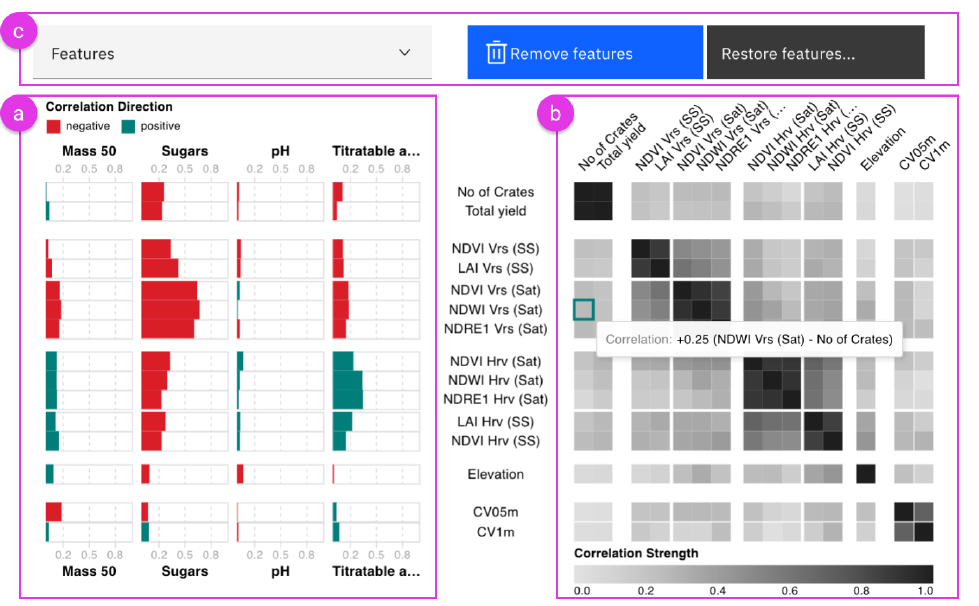
Figure 2. Interface for correlation analysis of multivariate data: ( a ) the bars showing the correlation of each feature with each of the target variables; ( b ) the grayscale showing the strength of the correlation between the features; ( c )